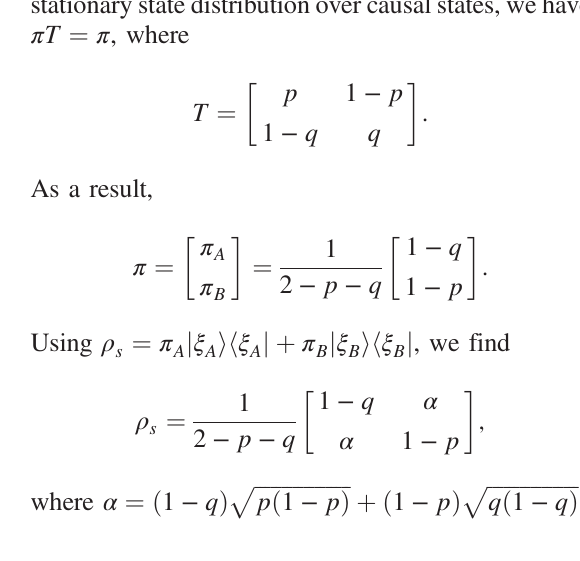
FIG. 12. A n , the set of words with length n , can be decomposed to different bubbles Λ P u;n , each labeled with different u